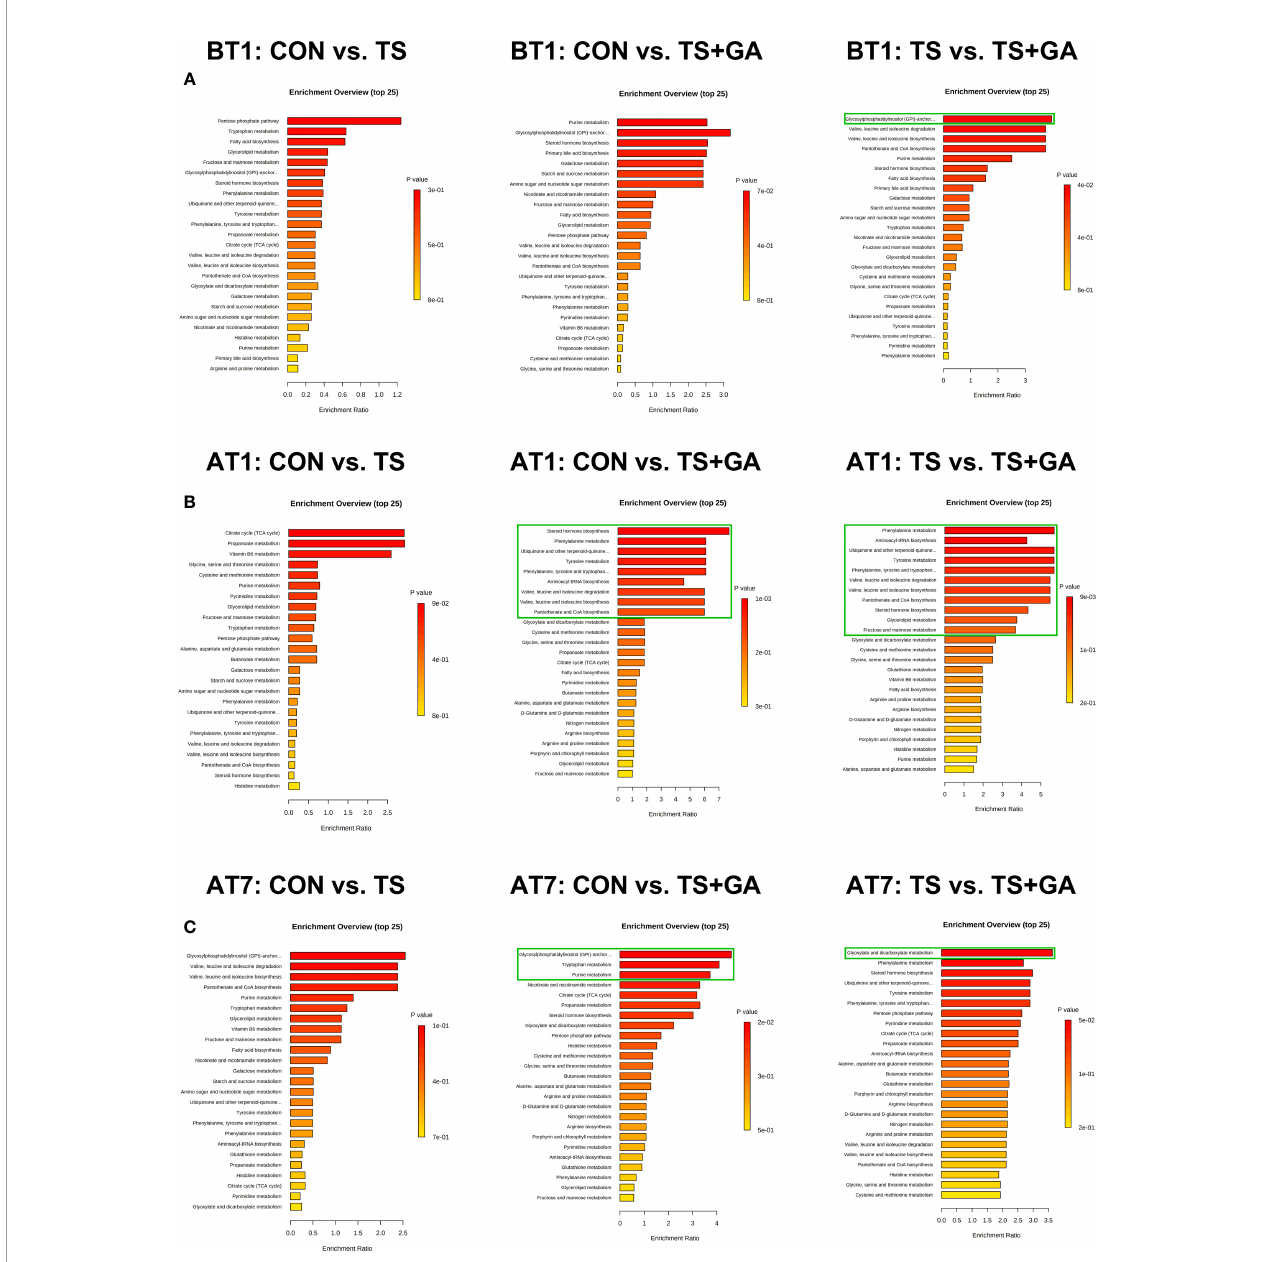
FIGURE 7 | Bar charts of the metabolic pathway analysis of differential fecal metabolites on BT1 (A) , AT1 (B) , and AT7 (C) (n = 6 or 7). The pathway enrichment analysis shows all matched pathways, and the green boxes indicate signi fi cant metabolic pathways ( p < 0.05). BT1, the 1st day before transportation; AT1, the 1st day after transportation; AT7, the 7th day after